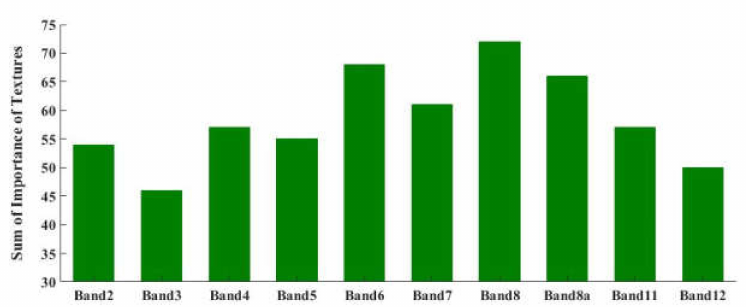
Figure 7. Importance of the texture feature set in each band according to the summation of all texture features selected per